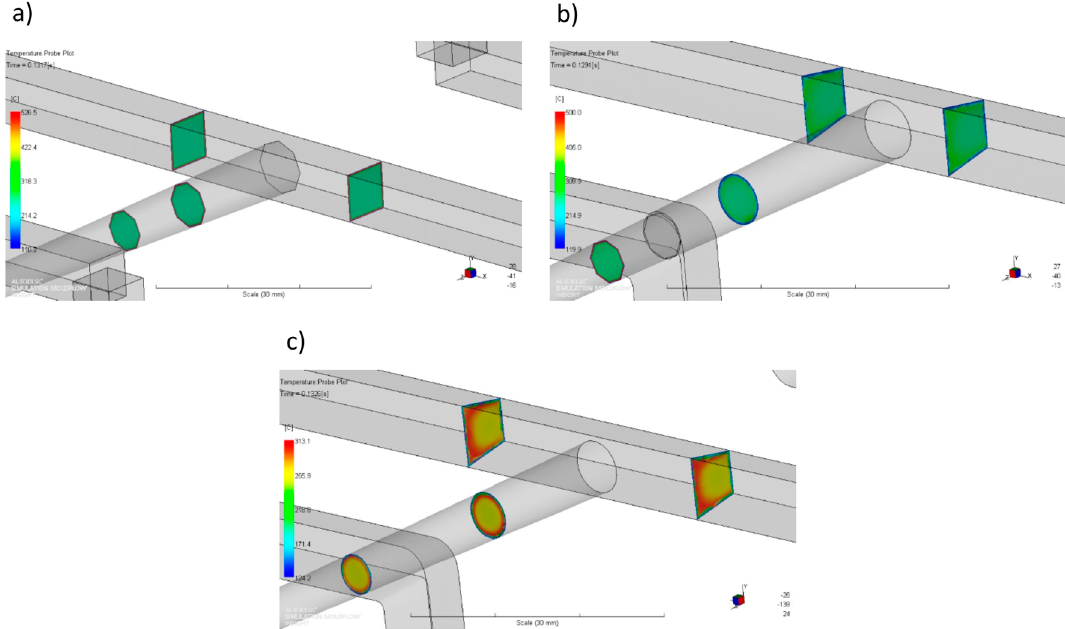
Figure 10. Meshing for runners modeling: ( a ) 1D conventional beam elements, ( b ) combination of 1D/3D elements, and ( c ) 3D meshing